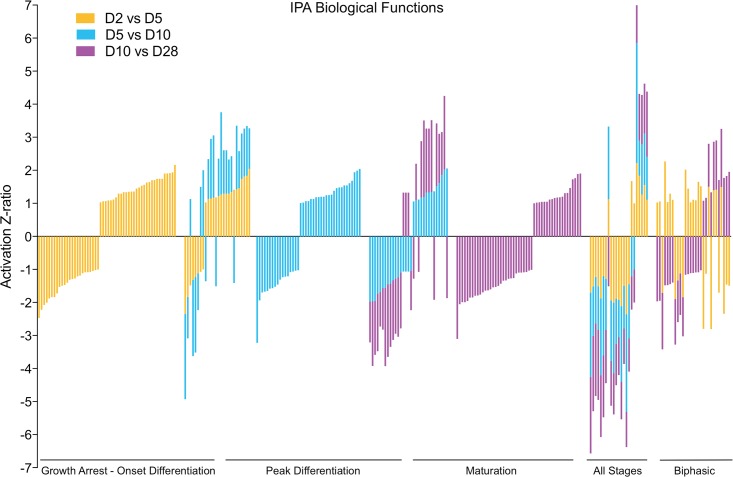
Temporal changes in mRNA abundance reflect evolving biological processes during MC3T3-E1 differentiation.The mRNA abundance of 976 significantly regulated genes identified by ANOVA as changing during MC3T3-E1 differentiation was used to calculate expression ratios comparing D2 vs D5, D5 vs D10, and D10 vs D28. For each pairwise comparison, the earlier time point was used as the denominator and later time point as the numerator, such that expression ratios reflect increases/decreases in mRNA abundance as differentiation proceeds. IPA Downstream Effects Analysis was performed to identify biological process terms associated with each interval and filtered to include terms only with –log(p value) >1.3, minimum of two genes, and z-score >1 or <-1. The graph depicts z-score values for terms associated with the period of growth arrest and onset of differentiation (gold bars), active differentiation (blue bars), and osteoblast maturation (lavender bars). The descriptive annotations associated with each term are omitted for simplicity but presented in S3 Table.